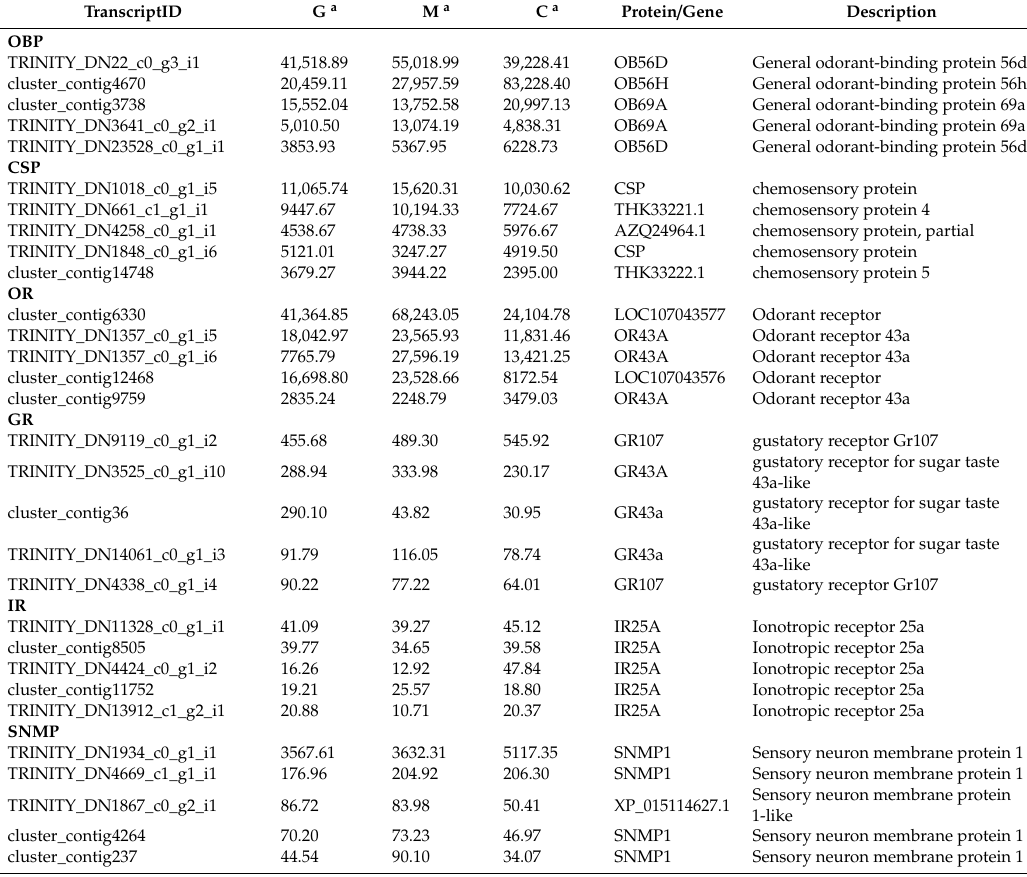
Table 3. Top five transcripts encoding olfactory proteins in Ashmead insects.